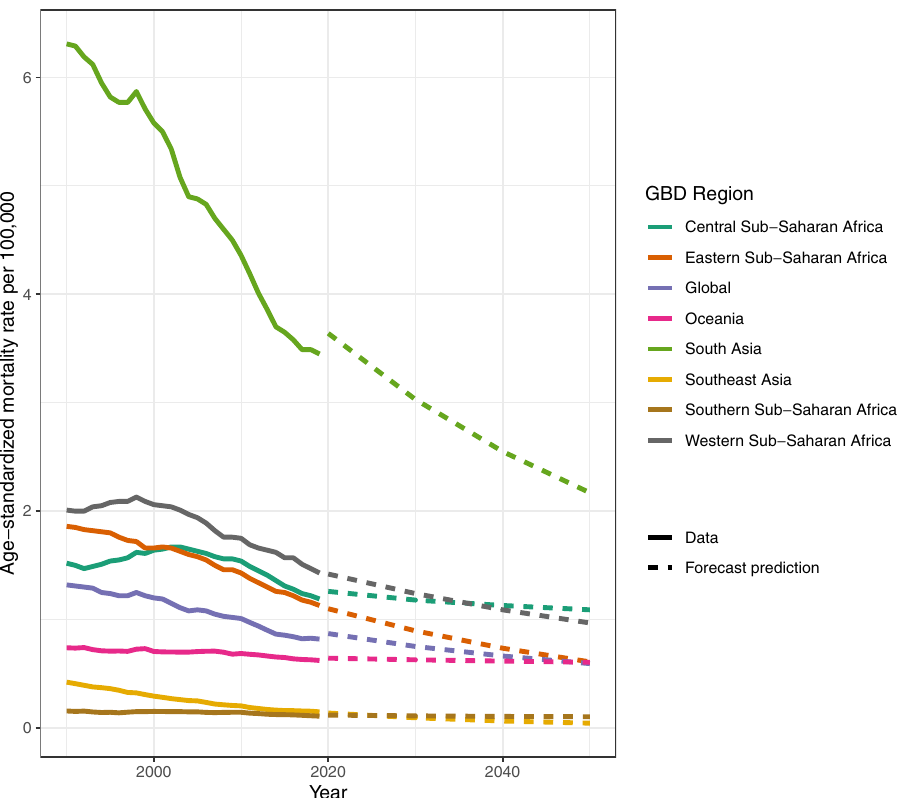
Fig. 4 | Global and regional age-standardized snakebite envenoming mortality rate from 1990 to 2019 with forecasting to 2050 of the seven regions with the highestsnakebiteenvenomingburden. Age-standardizedsnakebiteenvenoming mortality rate per100,000byregion and year,forecasted to2050.The plot shows the top seven regions in terms of age-standardized rates in 2019, all of which had age-standardizedmortalityratesgreaterthan0.1per100,000.Linesinboldarethe